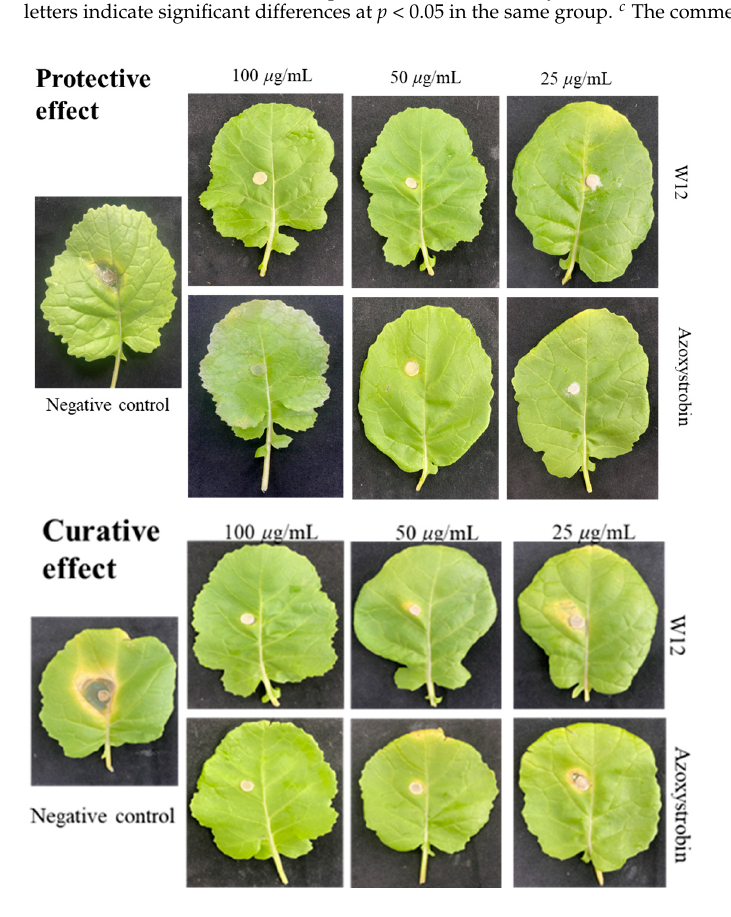
Figure 4. The curative effect and protective effect of W12 against S . sclerotiorum .